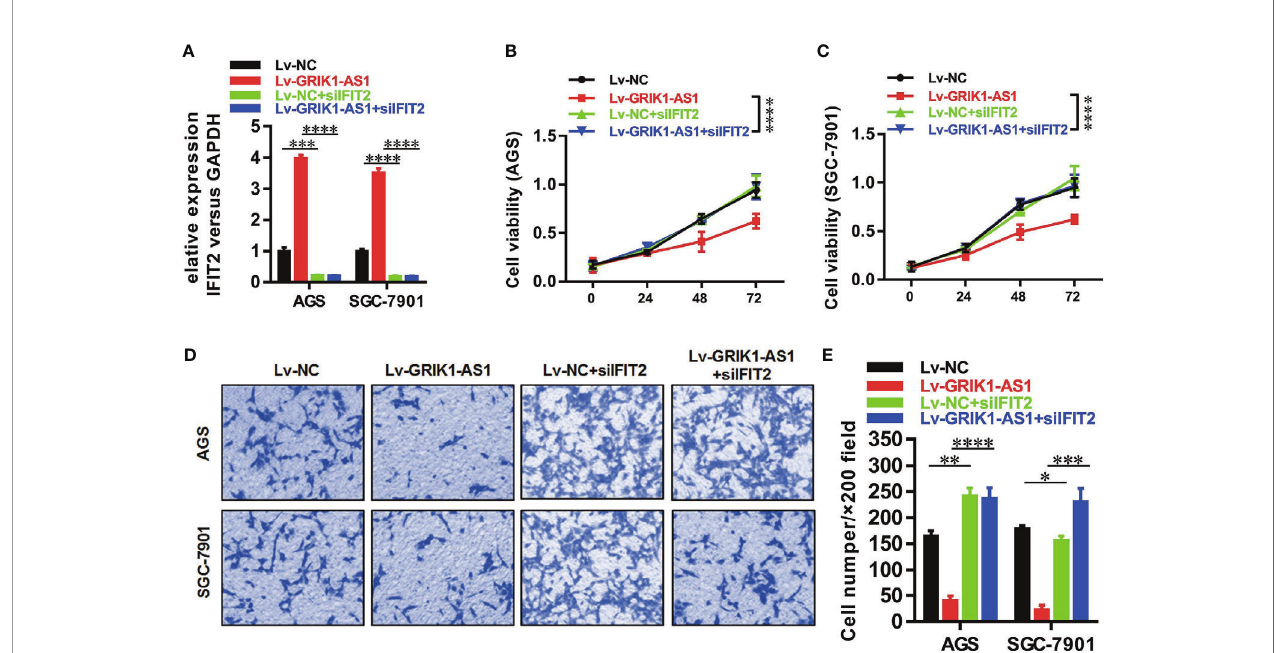
FIGURE 6 | IFIT2 knockdown reverses the suppressed cell proliferation and invasion capability caused by GRIK1-AS1 over-expression. (A) Real-time qPCR analysis of IFIT2 expression level in control and GRIK1-AS1 over-expressed AGS and SGC-7901 cells with or without IFIT2 knockdown. (B, C) Cell proliferation assays of control and GRIK1-AS1 over-expressed AGS and SGC-7901 cells with or without IFIT2 knockdown. (D, E) Transwell assays of control and GRIK1-AS1 over- expressed AGS and SGC-7901 cells with or without IFIT2 knockdown. * P < 0.05, ** P < 0.01, *** P < 0.005, **** P <